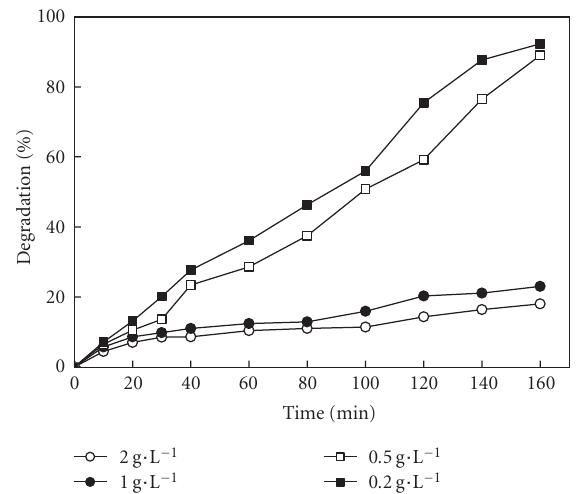
Figure 5: E ff ect of dye concentrations on photodegradation.